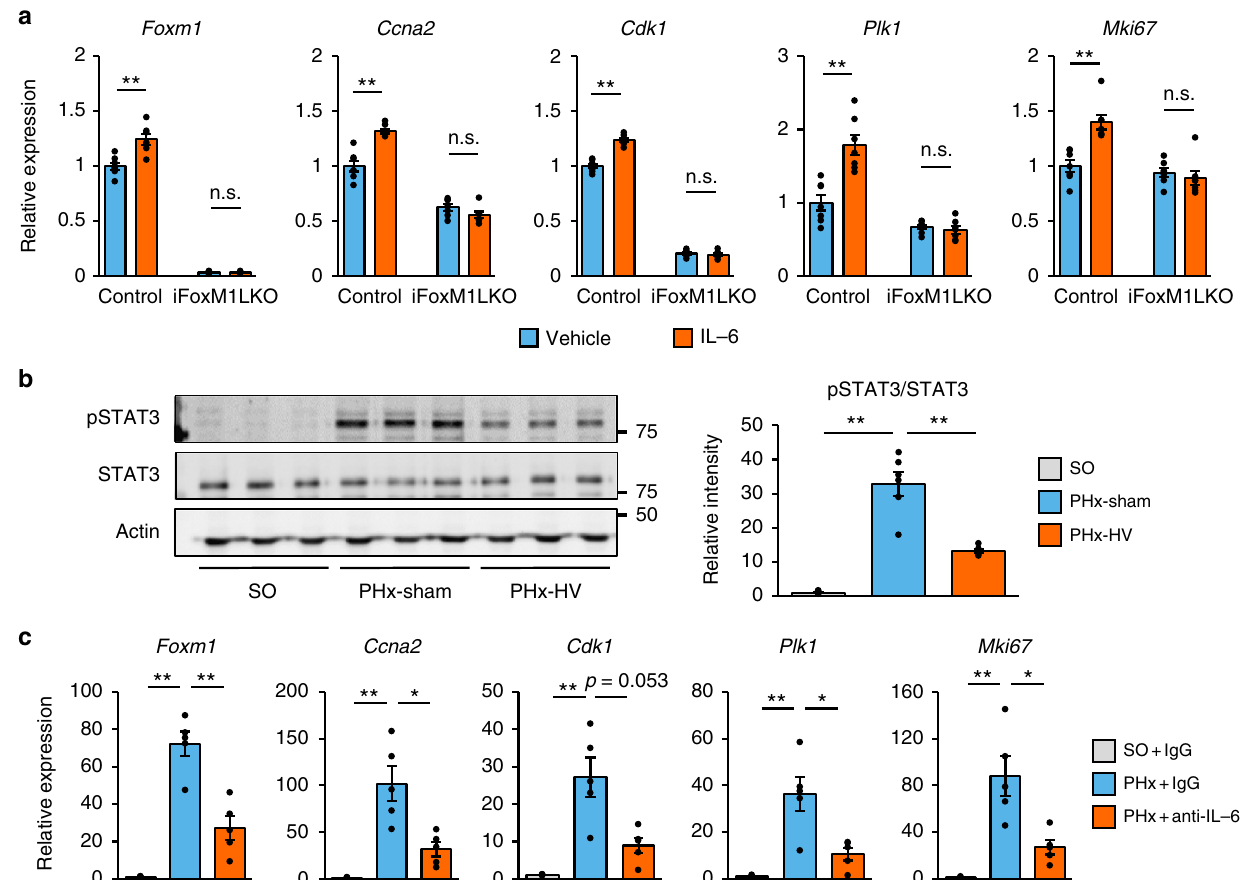
Fig. 7 IL-6 mediates vagal signal-induced hepatic FoxM1 activation. a Relative expressions of Foxm1 , its target genes, and MKi67 in primary hepatocytes isolated from control and iFoxM1LKO mice treated with 100 ng/ml IL-6 ( n = 7 – 8 per group) and vehicle ( n = 7 – 8 per group) for 6 h. b (Left panels) Representative images of liver extract immunoblottings with anti-phospho-STAT3, total STAT3, and actin. (Right panel) Relative intensities of phospho/ total STAT3 in livers from sham operation for PHx (SO)- ( n = 6), PHx-sham- ( n = 6), and PHx-HV mice ( n = 6). c Relative expressions of Foxm1 , its target genes, and MKi67 in the liver 2 days after surgery from SO + IgG ( n = 5), PHx + IgG ( n = 5), and PHx + anti-IL-6 antibody- ( n = 5) treated mice. Data are presented as means ± SEM. * P < 0.05; ** P < 0.01 assessed by unpaired t test ( a ), or assessed by one-way ANOVA followed by Bonferroni ’ s post hoc test ( b and c ). n.s., not signi fi